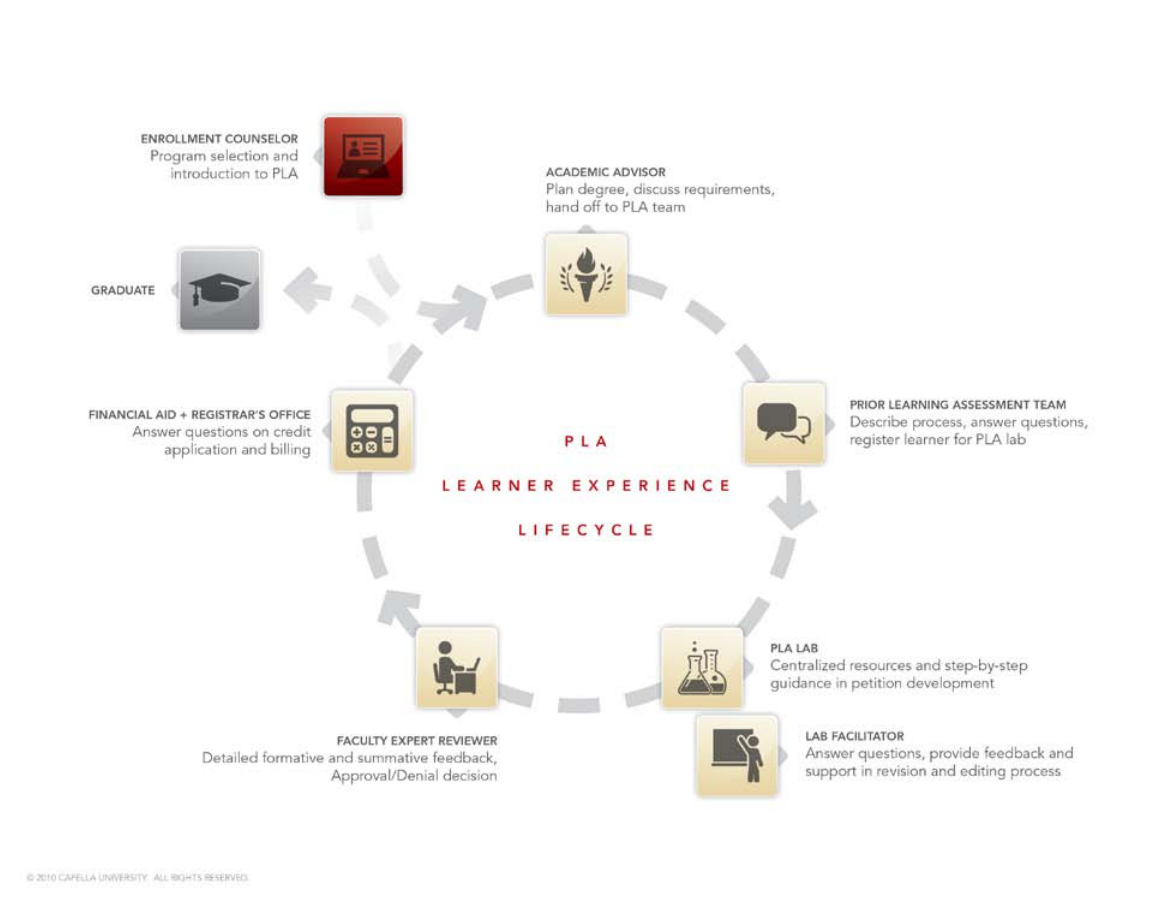
Figure 1 . PLA learner experience